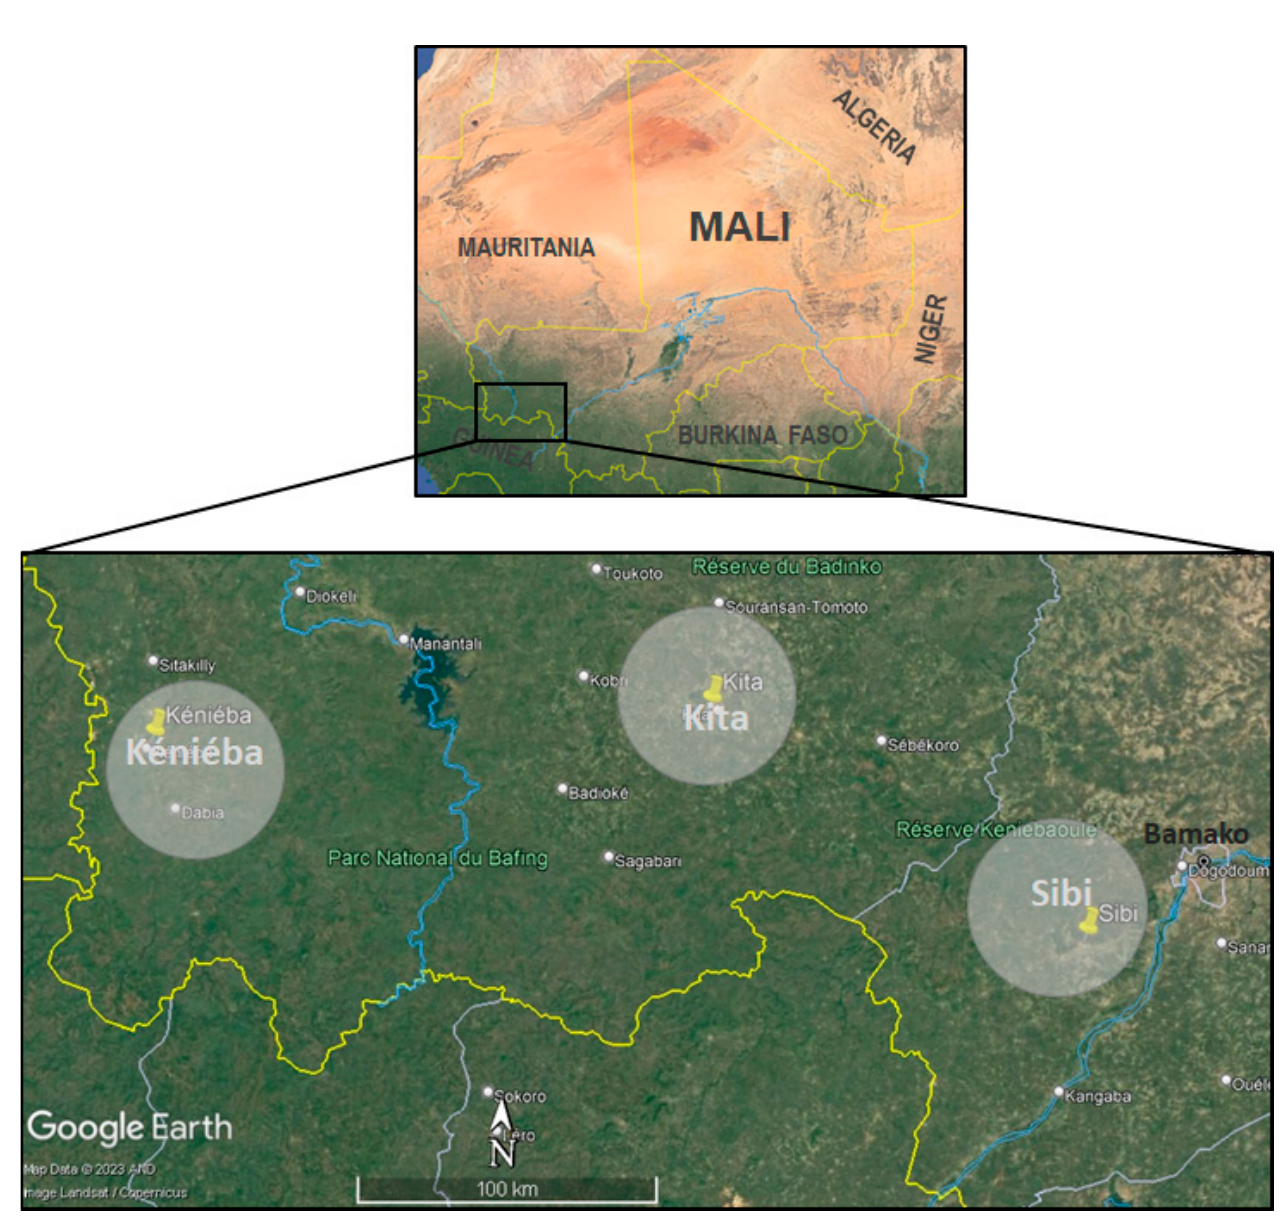
Figure 1. Map showing the area of origin of the studied woods. The 11 wood cross-sections correspond to four timber wood species: Daniellia oliveri , Isoberlinia doka , Khaya senegalensis , and Pterocarpus erinaceus , which are indigenous African tree species with a geographic distribution ranging from West to East Africa [28–30]. These species are associated with high natural resistance to the less favorable climatic conditions of the tropical arid Sahelian and semiarid Sudanian zones in the West African Sahel [31,32]. Further, the selected wood species are among the most used timber wood with vital importance for local economic development [33,34]. According to the IUCN Red List, D. oliveri and I. doka are registered as the least concerned species, whereas K. senegalensis and P. erinaceus are, respectively, indicated as vulnerable and threatened species [35–38]. Moreover, these species are being affected by widespread forest degradation because of increasing demand for forest products and excessive exploitation combined with the changing environmental conditions without appropriate regeneration measures